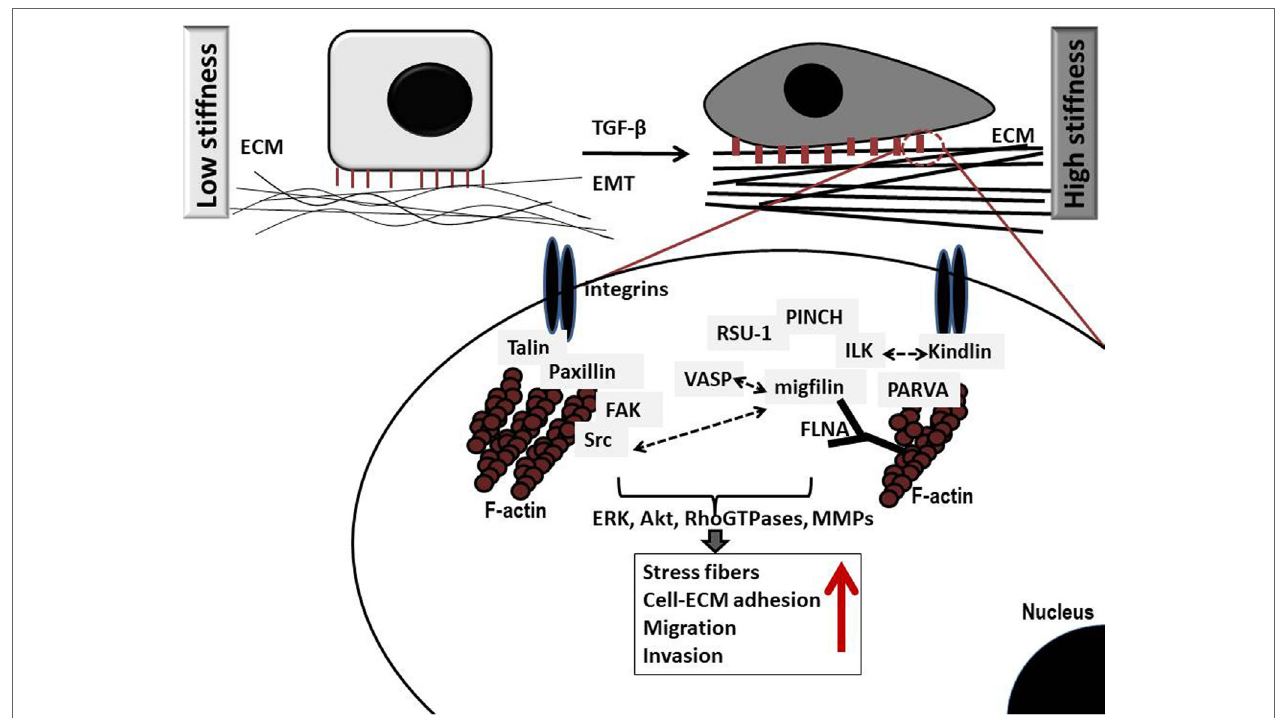
FigURe 1 | Schematic representation of critical protein–protein interactions at cell–extracellular matrix (ECM) adhesion sites in cancer cells grown in low (left) and high (right) stiffness conditions. Several important protein complexes are formed at the cell–ECM sites that are vital for normal cell function. More specifically, integrin-linked kinase (ILK) binds to the cytoplasmic domain of integrins and also interacts with particularly interesting new cysteine–histidine rich protein (PINCH)-1 and parvin alpha (PARVA) forming a stable ternary complex at cell–ECM adhesions known as PIP (PINCH–ILK–PARVA) or IPP (ILK–PINCH–PARVA) complex (31). PARVA, in turn, binds directly to actin connecting the complex to the cytoskeleton of the cell. ILK has also been shown to interact with Kindlin-2 (also known as mitogen-inducible gene-2 or Mig-2) which again forms a protein complex with Migfilin and filamin A (FLNA) (32), an actin-crosslinking protein. Interestingly, Migfilin has been shown to interact with vasodilator-stimulated phosphoprotein (VASP) (14), regulating cell migration. Equally important is the interaction of integrins with talin (33) and paxillin, which in turn binds to focal adhesion kinase (FAK) (34) while FAK binds to Src (35), which has been also shown to interact with Migfilin regulating cell–ECM mediated survival (36). Note that all cell–ECM adhesion proteins have direct or indirect connection to the actin cytoskeleton, while they activate downstream effectors such as the RhoGTPases, and matrix metalloproteinases (MMPs) eventually leading to regulation of vital cellular functions (proliferation, survival, migration, and invasion). Notably, higher stiffness conditions are associated with marked increase in the amount of stress fibers as well as increased migration and